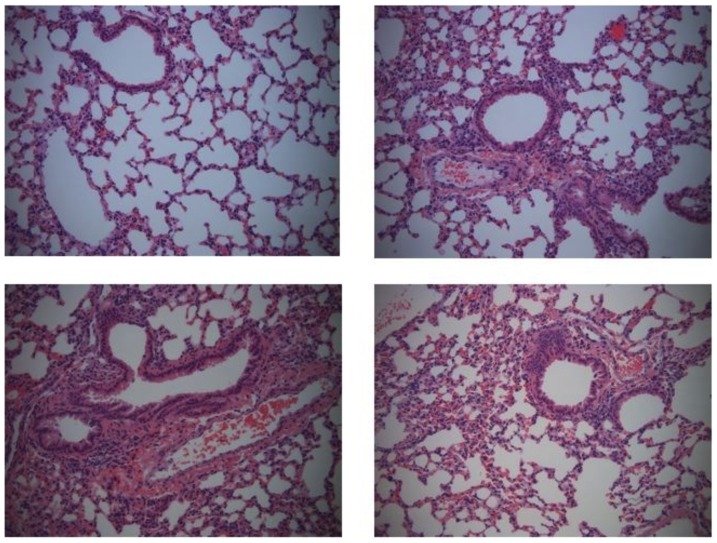
Infiltration of neutrophils and macrophages in c-di-GMP treated animals.(A) Photomicrograph of lung biopsies taken from a control mouse at 24 hr post treatment with c-GMP, obtained with a 10 X objective plus digital zoom. (B-D) Photomicrographs of lung biopsies taken from three different mice at 24 h post treatment with c-di-GMP (10 X objective plus digital zoom).